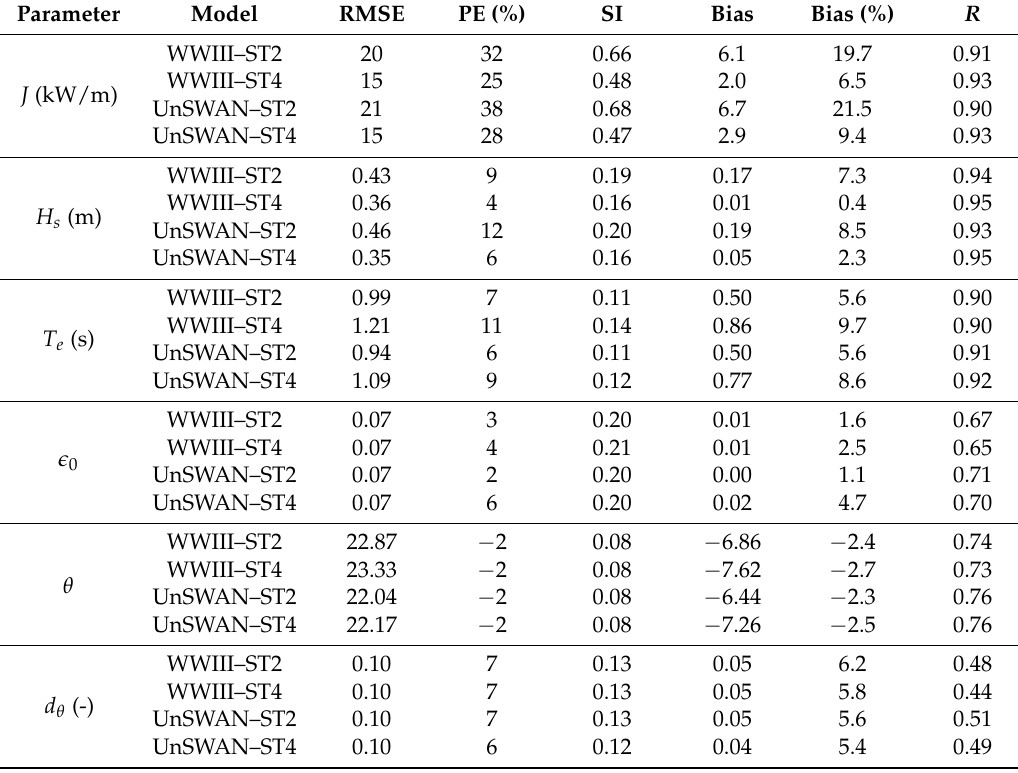
Table 2. Performance metrics for WWIII and UnSWAN using the ST2 and ST4 physics packages.